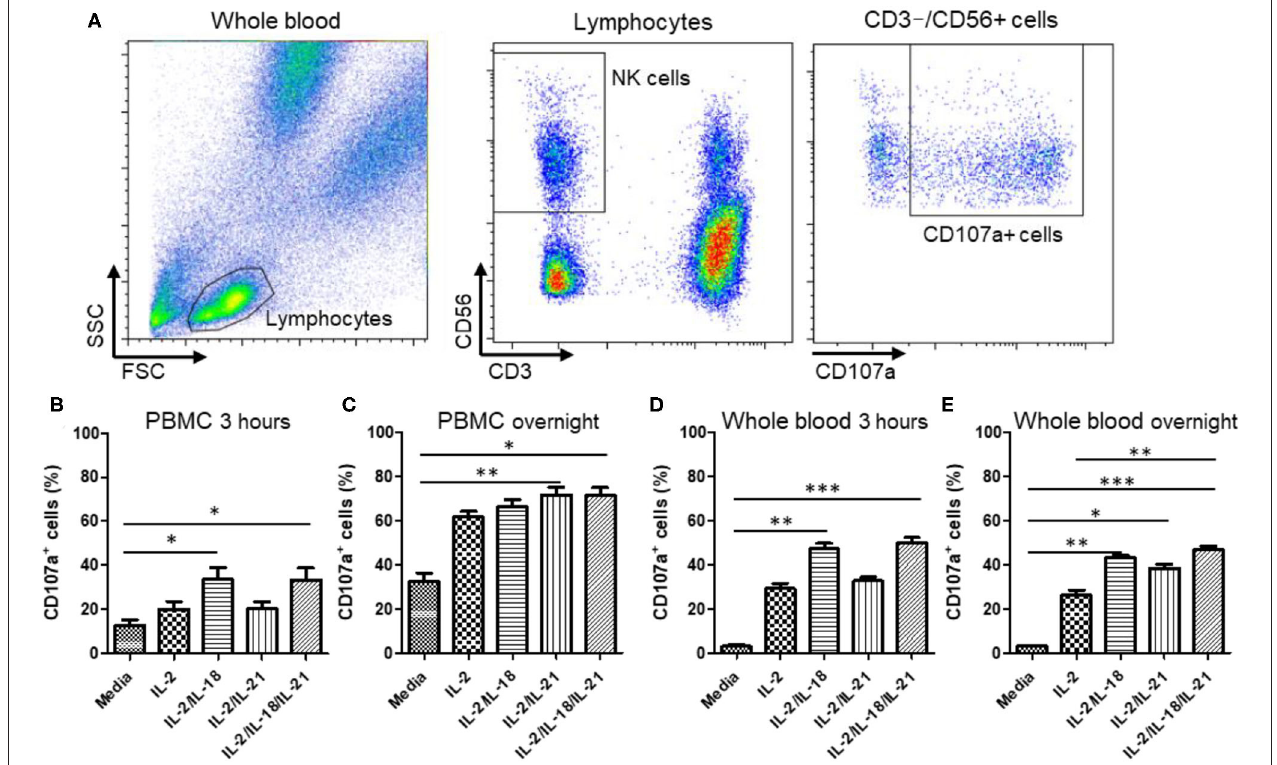
FIGURE 2 | CD107a expression of peripheral blood mononuclear cells (PBMCs) and whole blood (WB) under various cytokine combinations and incubation times. PBMCs or WB samples were mixed with media containing various cytokine combinations (no cytokines (media), IL-2, IL-2/IL-18, IL-2/IL-21, and IL-2/IL-18/IL-21) for the indicated durations of time, and CD107a assays were performed either immediately or following overnight incubation. Samples were incubated for 3h with or without K562 cells. (A) Gating strategy of CD107a measurement. CD107a surface expression was determined as CD3 − CD56 + CD107a + by flow cytometry. (B,C) Bar graphs indicate the percentage of CD107a + NK cells in PBMCs following cytokine stimulation for 3h or overnight. (D,E) Bar graphs indicate percentages of CD107a + NK cells in WB following cytokine stimulation for 3h and overnight. Data are represented as the mean ± SEM of results from five donors (* p < 0.05; ** p < 0.01; *** p <